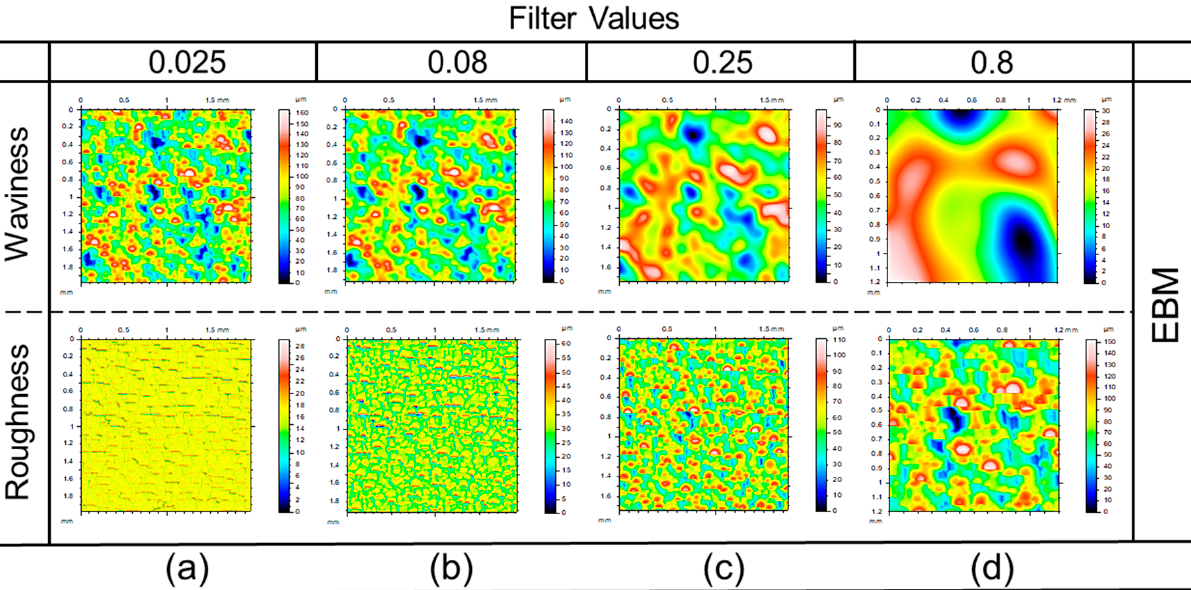
Figure 11. Surface topography of as-built LENS surface after filtering. The above investigations show that selecting a proper λ c plays a significant role in determining the resulting waviness and roughness. For an AM component, if the size dis- tribution of each type of asperity is known, the above results show that the textural vari- ations arising from each type of asperity present on the surface can be identified and quan- tified separately.